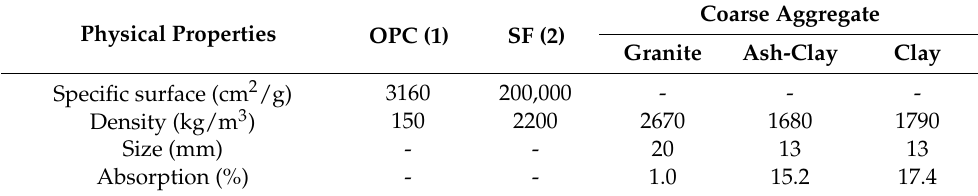
Table 2. Physical properties of